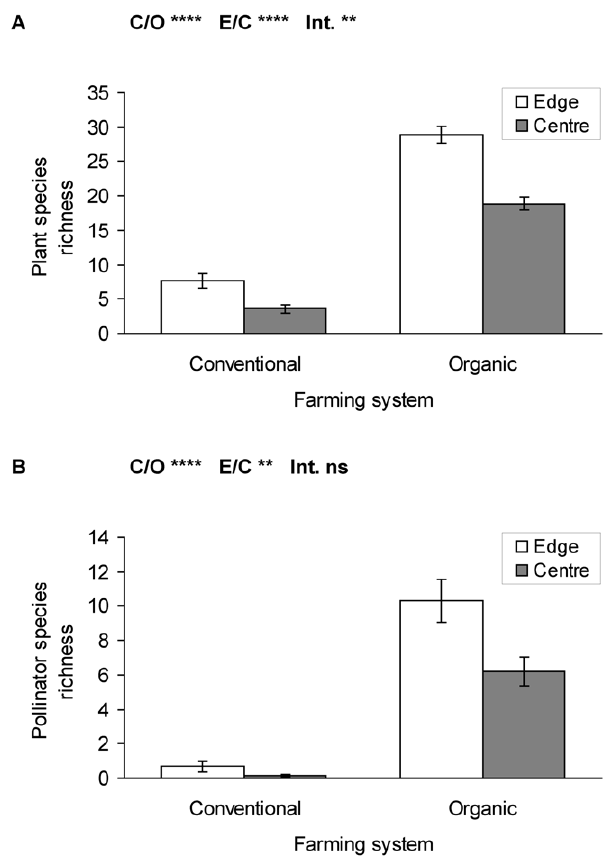
Figure 2. Species richness of (a) vascular plants and (b) pollinators in conventional and organic triticale field edges and centres (mean ± se). C/O: conventional/organic fields, E/C: edge/centre in field, Int: Interaction term. **** p # 0.0001, ** p # 0.01, ns